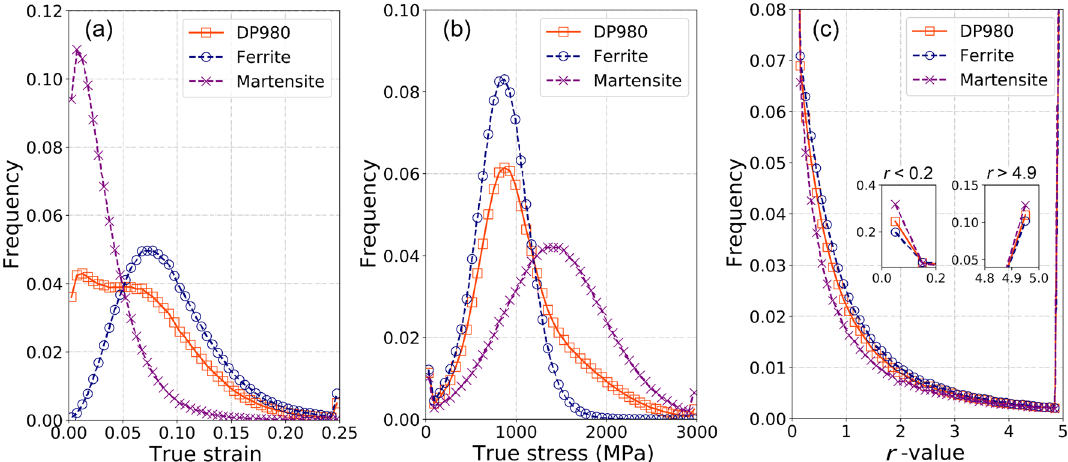
Figure 11. The histograms of the frequency distribution of true strain (bin size 0.005), true stress (bin size 60 MPa), and r -value (bin size 0.1) of the DP-RVE and the separated F-RVE and M-RVE. The RVE was subjected to uniaxial tension in RD at the specific plastic work of 60 MPa. The true stress and true strain correspond to the components in tensile